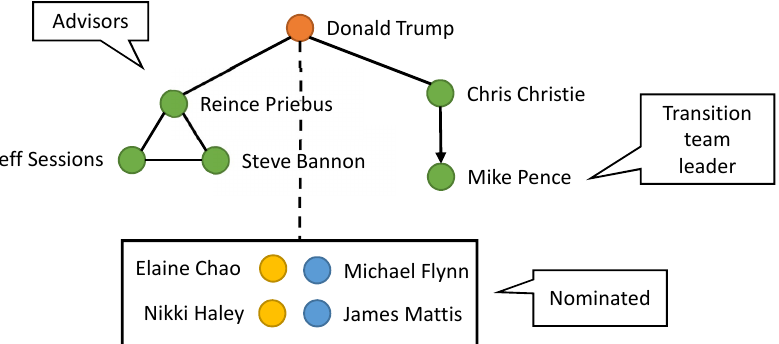
Figure 5: A typical and fictional example of a reasoning graph inspired by the one found in Jigsaw’s